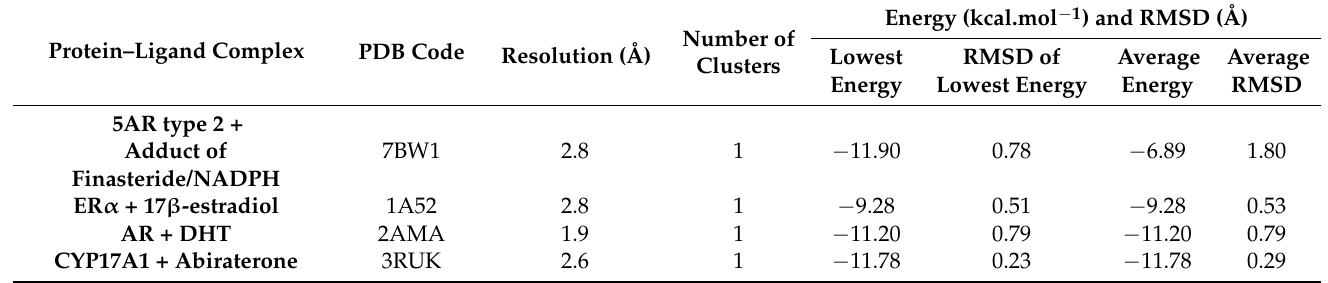
Table 3. Results of re-docking using GA of protein–ligand complexes, PDB accession codes and resolution 1